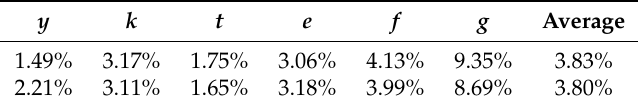
Table 15. Percentage differences from original